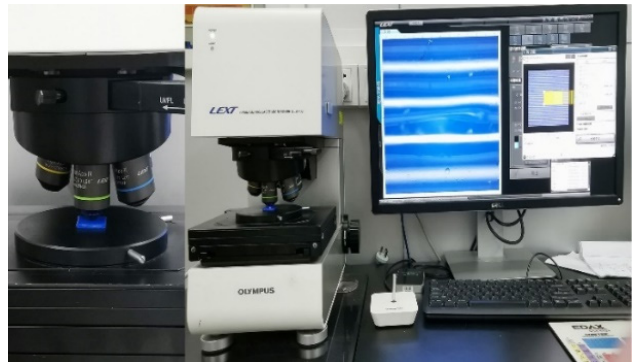
Figure 9. The surface roughness test equipment and samples.